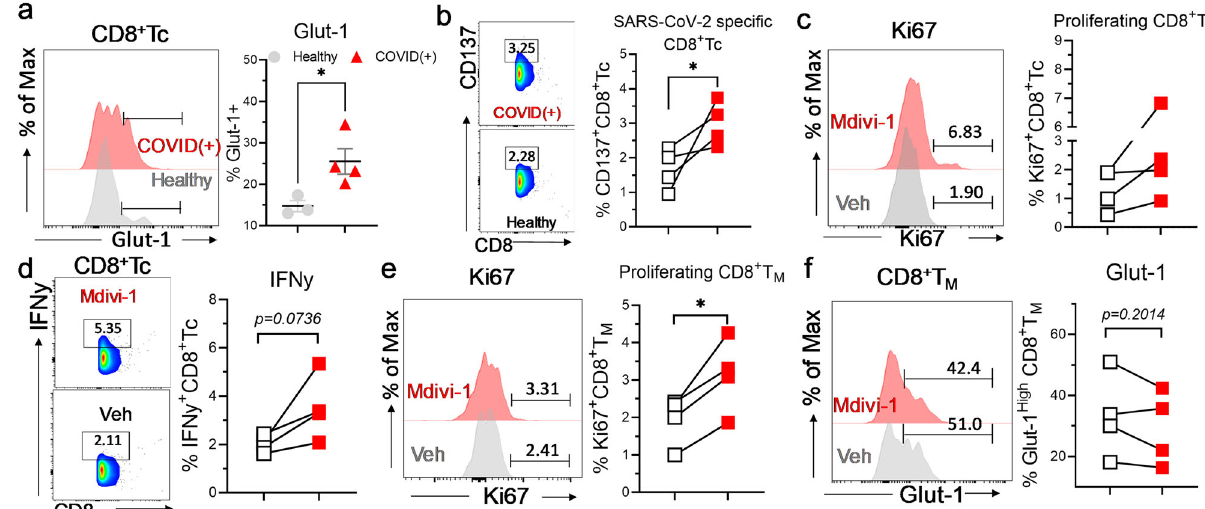
Fig. 8 Mitophagy inhibition restores CD8 + Tc and SARS-CoV-2-speci fi c CD8 + Tc function. PBMCs from COVID-19( + ) patients were activated with SARS-CoV-2 megapool CD8a peptide (see Methods) in the presence or absence of mdivi-1 (20 µ M). One sample was excluded from analysis due to critically low CD8 + Tc count. a Representative histogram and summary graphs demonstrating the expression of glut-1 in CD8 + Tc from healthy and COVID( + ) patients ( n = 3 HD, 4 C). b – d Representative histogram/density plots and graphs demonstrating the abundance of antigen-speci fi c (CD137 + ) ( n = 4 C) ( b ), Ki-67 + ( n = 4 C) ( c ), and IFNy + ( n = 4 C) ( d ) cells among CD8 + Tc of vehicle or mdivi-1 vs vehicle-treated samples. e , f Representative histogram and summary graphs demonstrating the abundance of Ki-67 + ( n = 4 C) ( e ) and glut-1 + ( n = 4 C) ( f ) cells amongst CD8 + T M of vehicle or mdivi- 1-treated samples. Two-tailed student ’ s t test was used. * p < 0.05, ** p < 0.01, and *** p < 0.001.